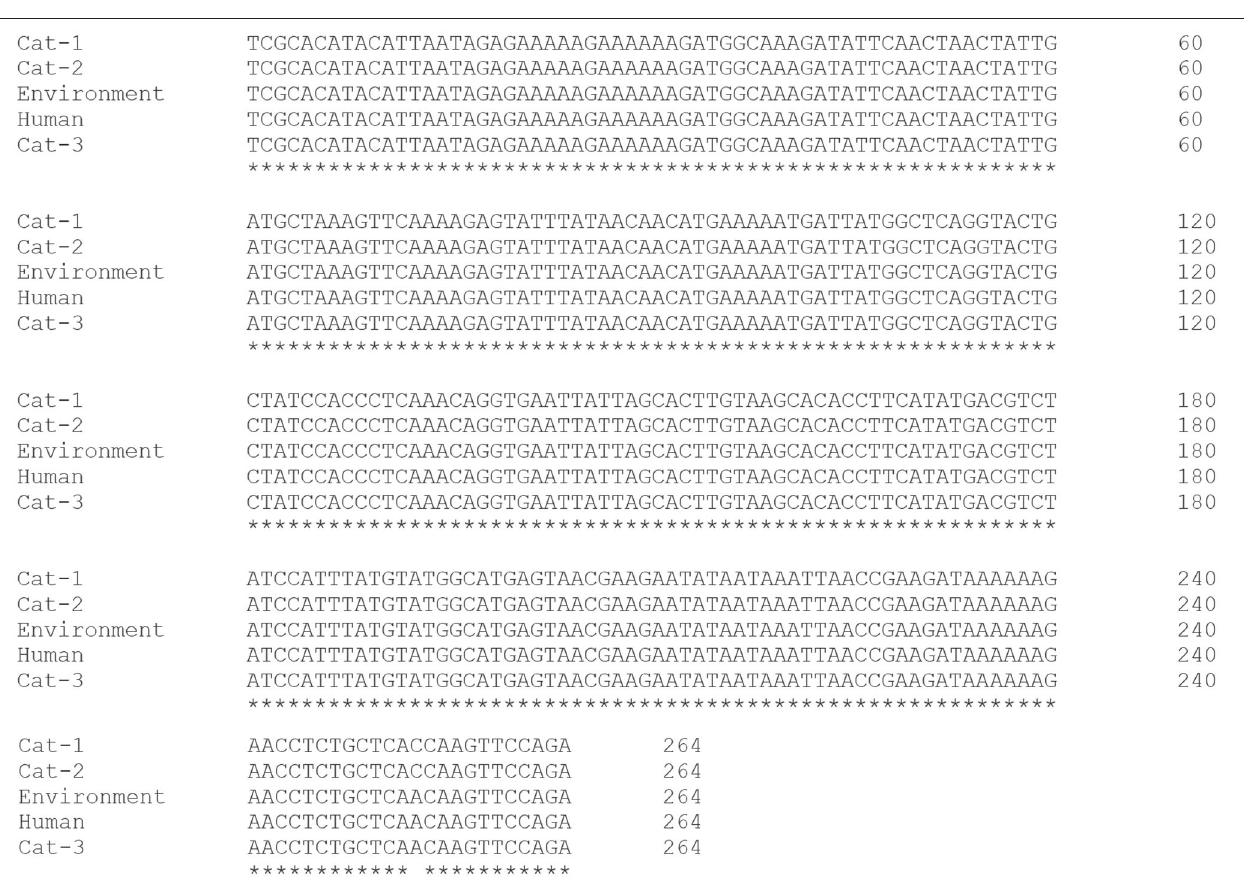
Frontiers in Veterinary Science |